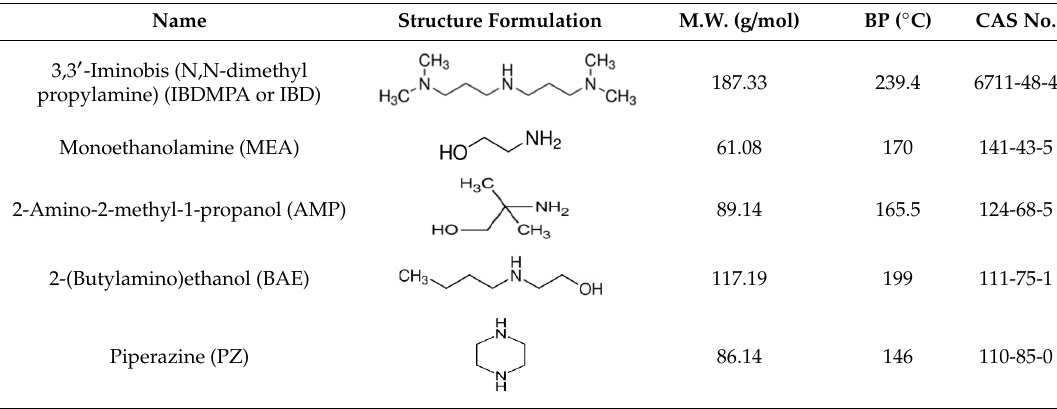
Table 1. List of amines associated with this study.